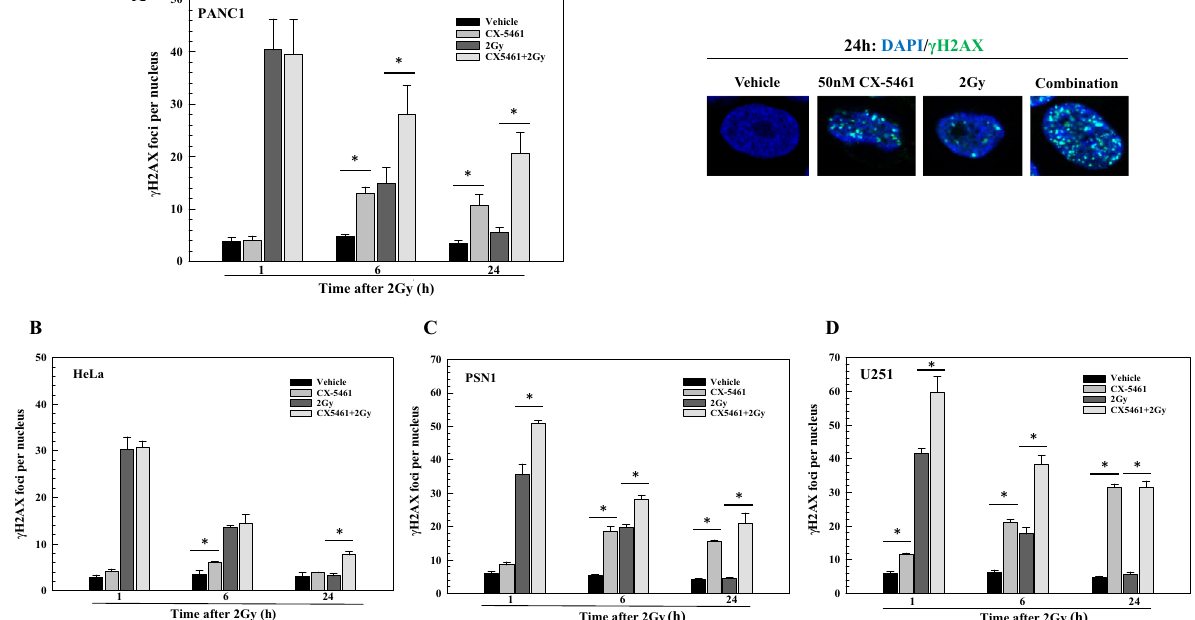
Figure 4. γH2AX foci analysis after cell exposure to CX-5461, 2 Gy, or the combination. γH2AX foci were determined in PANC-1 ( A ), HeLa ( B ), PSN1 ( C ), and U251 ( D ) cells. 50 nM CX-5461 was added to cultures 1 h prior to irradiation (2 Gy) and cells were collected at the indicated time points for foci analysis. γH2AX foci were counted in 50 cells per treatment group. Representative images of γH2AX foci in PANC-1 at 24 h are shown in ( A ). Values represent the mean ± SEM for three independent experiments. * p < 0.05 by Student’s